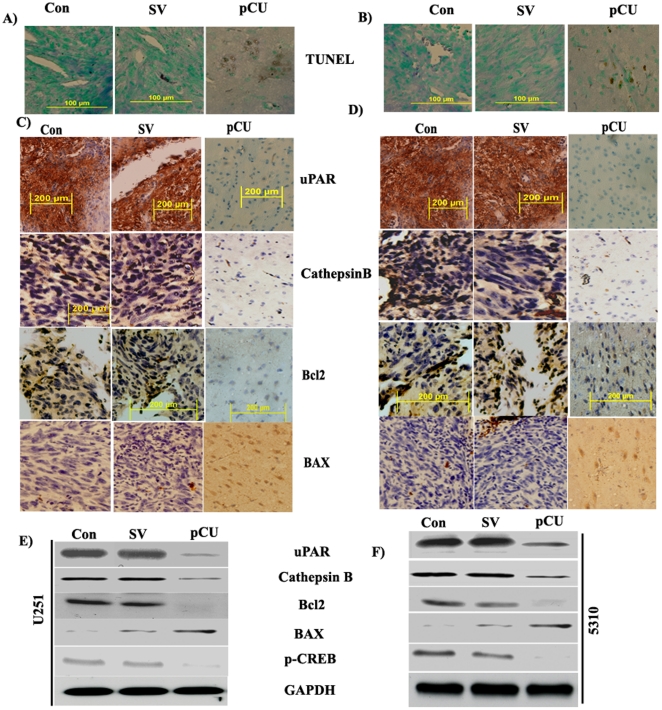
RNAi-mediated downregulation of uPAR and cathepsin B induces apoptosis in pre-established intracranial tumors.Intracranial tumors were established in nude mice by injecting U251 and 5310 cells that were treated with SV and pCU as described in Materials and Methods. (A–B) The brains were embedded in paraffin, sectioned and stained for apoptosis by TdT-mediated nick end-labeling (TUNEL) followed by DAB staining. Nuclei were counterstained with methyl green. Data shown are representative of five fields. Brown stain around green nuclei indicates apoptotic cells. (C–D) Immunohistochemical analysis of uPAR, cathepsin B, Bcl-2 and Bax was performed in paraffin-embedded U251 and 5310 tumor sections. Appropriate protein-specific antibodies were used. Fields with brown staining as a result of DAB interaction were scored for protein expression. (E–F) uPAR and cathepsin B, Bcl-2 and Bax expression was detected in tumor tissue lysates from intracranial tumors of mice that received SV and pCU. Results are representative of three separate experiments.